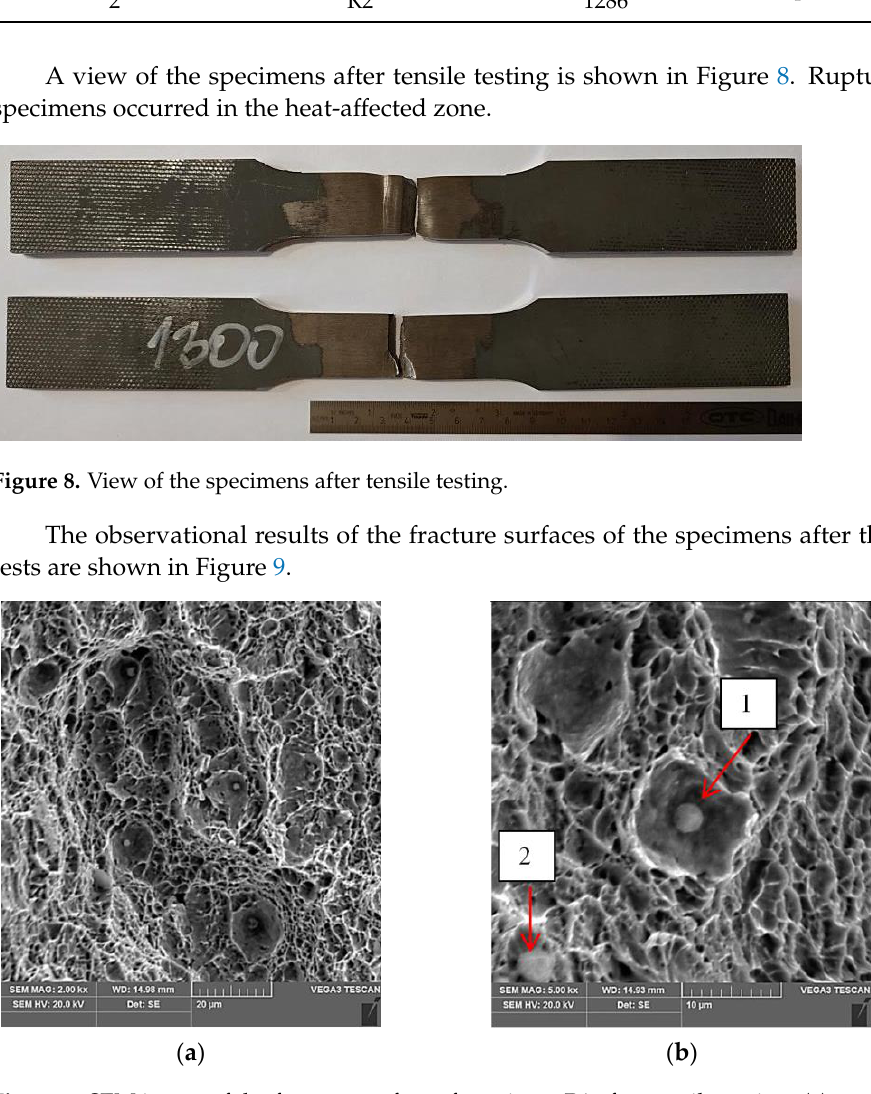
Figure 9. SEM image of the fracture surface of specimen R1 after tensile testing: ( a ) magnification 2.00 kx; ( b ) points 1 and 2 mark the places where a quantitative point X-ray microanalysis was performed, magnification 5.00 kx.